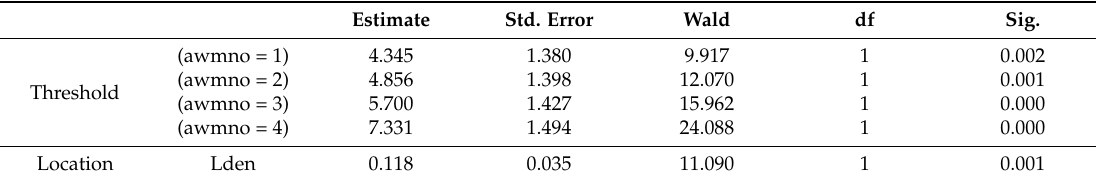
Table A1a. Estimated parameters of a simple exposure–effect relationship between noise exposure (Lden) and wind turbine noise annoyance without control for sensitivity, visual aesthetics or attitudes. n = 87.